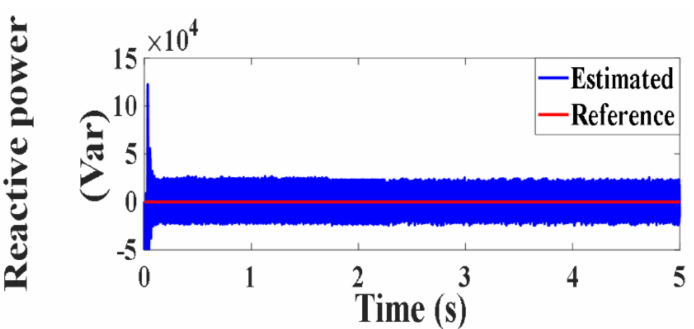
Figure 39. Reactive power under MPDTC (var).